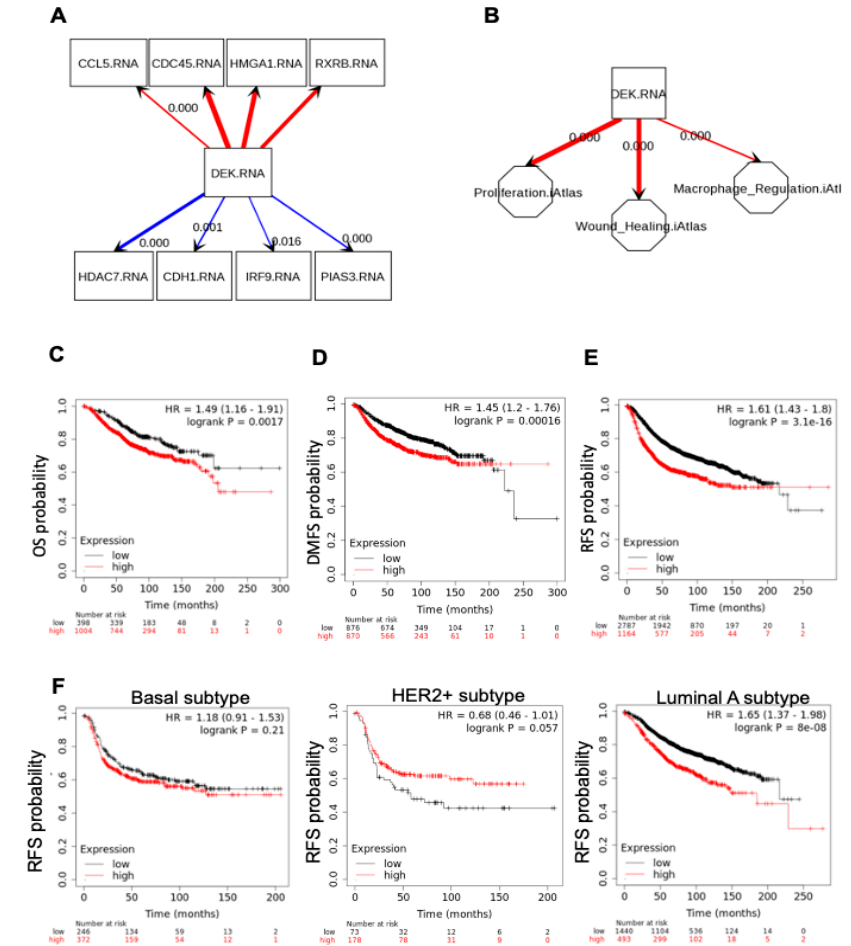
Figure 5. Gene expression profiles of Dek-expressing murine breast cancers are also detected in primary human breast cancers. SEMA software was utilized to plot correlations of expressed genes in breast cancers using data from The Cancer Genome Atlas (TCGA). ( A ) Genes that are up-regulated (positively correlated, top) and down-regulated (negatively correlated, bottom) with DEK expression in human breast cancer are depicted. Genes shown were selected from the list of genes in Table 1 that were found to be correlated in the mouse model. ( B ) A model of down-stream consequences of DEK expression based on gene expression correlations in primary human breast cancers that overlaps with the Dek-proficient and -deficient mouse model. SEMA software was used to query the association of DEK with cancer phenotypes in the Pan-Cancer Atlas. DEK expression positively correlates with proliferation, macrophage regulation, and a wound healing (M2-like) profile. For SEMA maps, red arrows depict positive correlations and blue arrows depict negative correlations. The thickness of the arrow represents the strength of the correlation, with p values shown when possible. If p values are not shown, then p < 0.0001. ( C–F ) KM plotter mRNA for breast cancer database was utilized to assess the association between DEK and CD163 expression on overall survival ( C ), distant metastasis-free survival ( D ), relapse free survival ( E ), and overall survival among di ff erent intrinsic molecular subtypes of breast cancer ( F